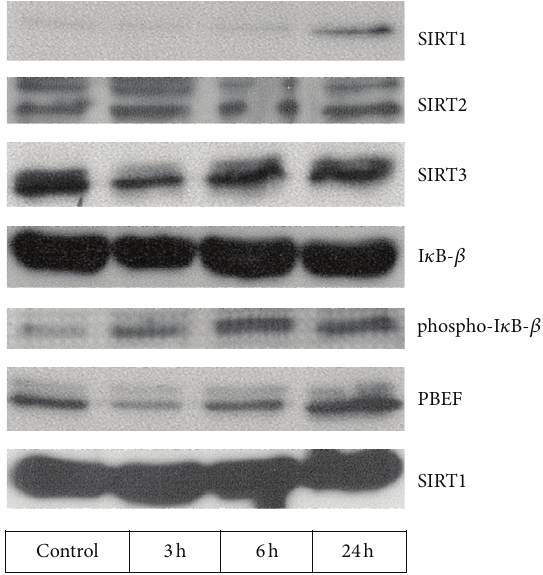
Figure 2: Protein expression of SIRT1, SIRT2, SIRT3, I 𝜅 B- 𝛽 , phospho-I 𝜅 B- 𝛽 , PBEF, and 𝛽 -actin in isolated PBMC incubated with LPS. An upregulation of SIRT1 protein expression was detected 24 hours following LPS. SIRT2 protein expression was unchanged. SIRT3 decreased 3 hours after LPS. I 𝜅 B- 𝛽 expression was decreased 3 hours after LPS, and phosphorylated I 𝜅 B- 𝛽 was upregulated following LPS administration. PBEF showed first a decrease after 3 and 6 hours and an increase after 24 hours following LPS.